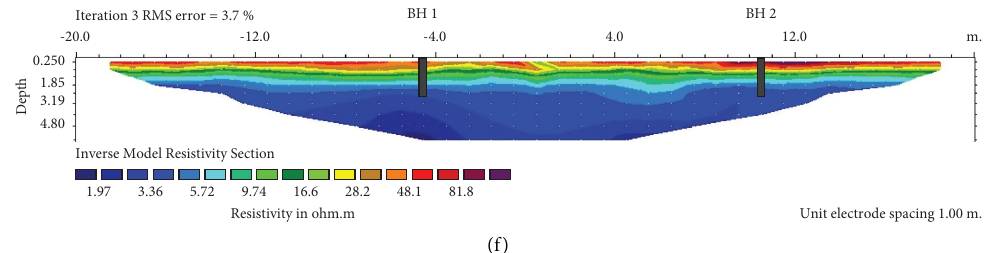
Figure 3: (a)–(f) Pseudosections of resistivity survey for